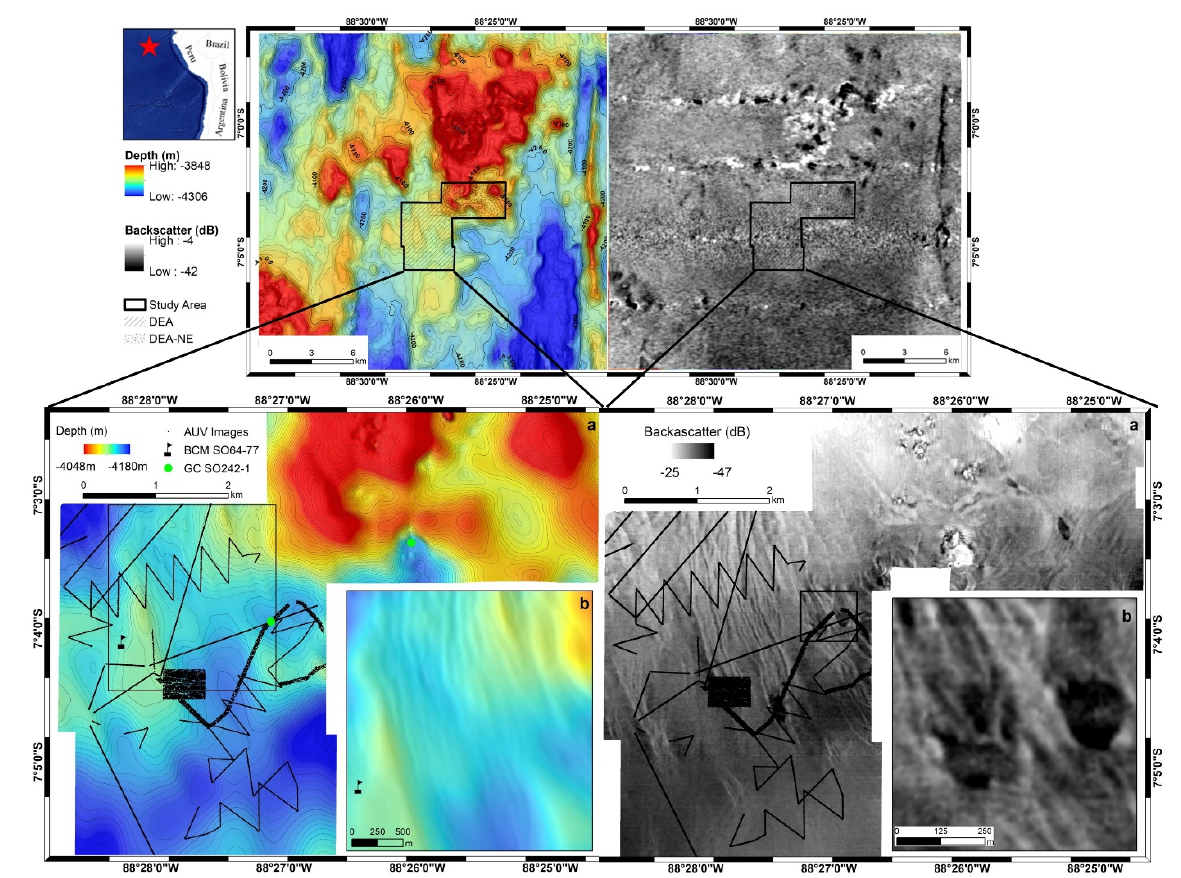
Figure 1. Top left: bathymetric map of the surveyed area in the northern Peru Basin (Southeast Pacific) during research cruise SO242-1 [77]. The area is characterized by N–S orthogonal striking graben and horst structures, sea mountains, knolls and hills with steep slopes, local depressions, and pit structures [67]. Top right: ship-based MBES backscatter mosaic map of the same area. The AUV mapped DEA and DEA-NE areas are indicated as a shaded black polygon. Bottom left: ( a ) DEA and DEA-NE AUV-based bathymetry with photo locations crisscrossing the area (black points). The contours have a 2 m depth interval. GC: gravity corer [69], BCM: bottom current measurements [71]. Map ( b ) is an enlarged map showing the abyssal furrows. The furrow height is up to 2 m. Bottom right: ( a ) DEA and DEA-NE AUV-based backscatter map. The northern part has a higher backscatter intensity than the central and southern parts because of the higher number of PMN. Backscatter alternations are also created by the presence of abyssal furrows; ( b ) two of the three low reflectivity black patches (PMN-free) that can be identified in the DEA.